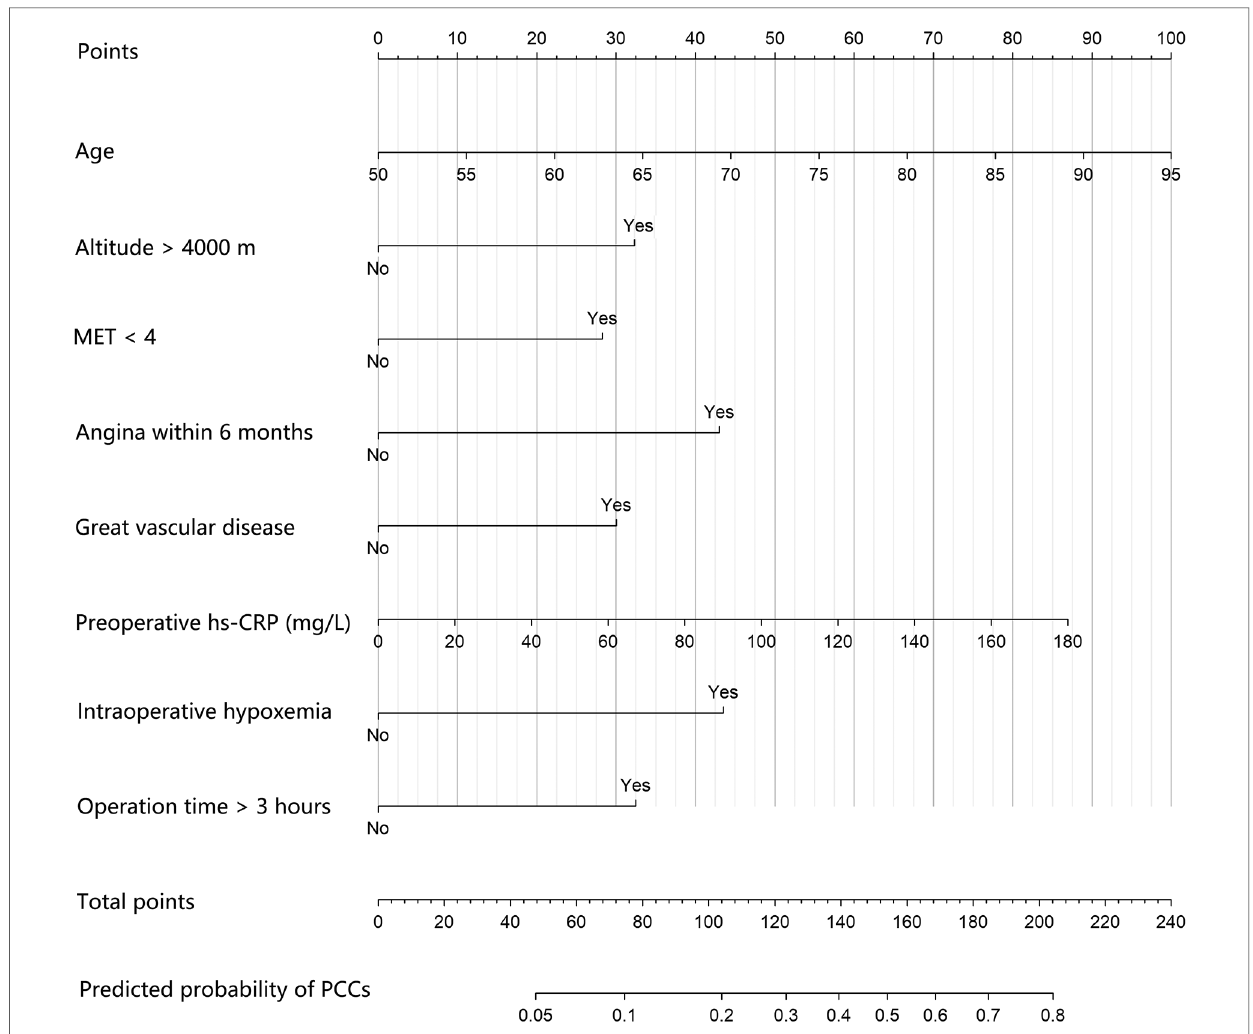
FIGURE 3 The prognostic nomogram of PCCs for patients undergoing major noncardiac surgery in high-attitude areas. An individual ’ s value is located on each variable axis, and a line is drawn upward to determine the points received for each variable. Corresponding points for each clinical factor are as follows: 50 to 95 years old correspond to 0 to 100 points, respectively; 33 points for high altitude and 0 points for not; 28 points for preoperative MET<4 and 0 points for not; 43 points for history of angina within 6 months and 0 points for not; 30 points for history of great vascular disease and 0 points for not; 0 to 180 mg/L preoperative hs-CRP correspond to 0 to 87 points, respectively; 44 points for intraoperative hypoxemia and 0 points for not; 33 points for operation time >3 h and 0 points for not. The sum of these points is located on the total point axis, and a line is drawn downward to the survival axes to determine the likelihood of PCCs. PCCs, perioperative cardiac complications; MET, metabolic equivalent; hs-CRP: high sensitivity C-reactive